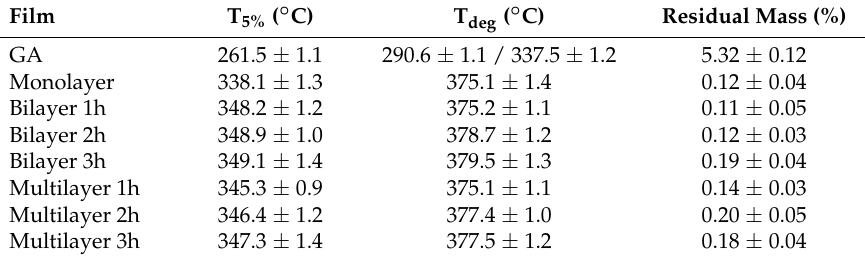
Table 3. Thermal degradation properties in terms of the onset degradation temperature (T 5% ), degradation temperature (T deg ), and residual mass at 650 ◦ C of gallic acid (GA) and the GA-containing polylactide (PLA)